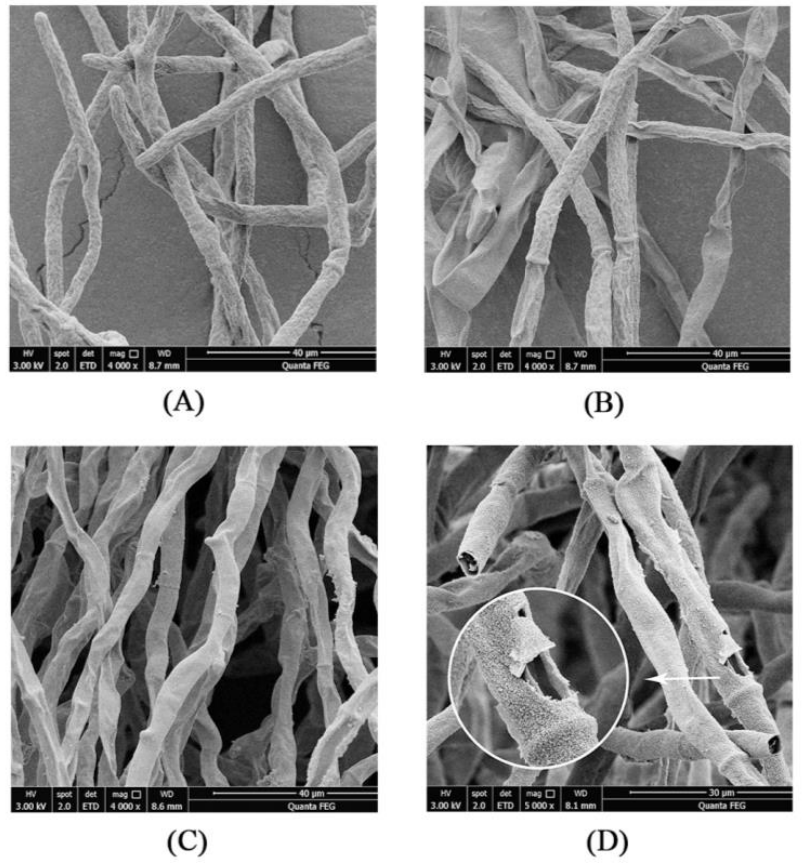
Figure 6. Effects of EOs on the microstructure of strain YQM mycelium: ( A ) control; ( B ) treated with CEO at 0.25 µL/mL; ( C ) treated with LEO at 2 µL/mL; ( D ) treated with CLCEO at 0.25 µL/mL.